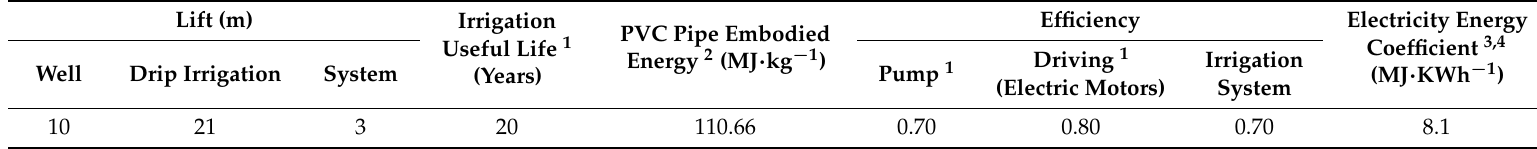
Table 4. Irrigation